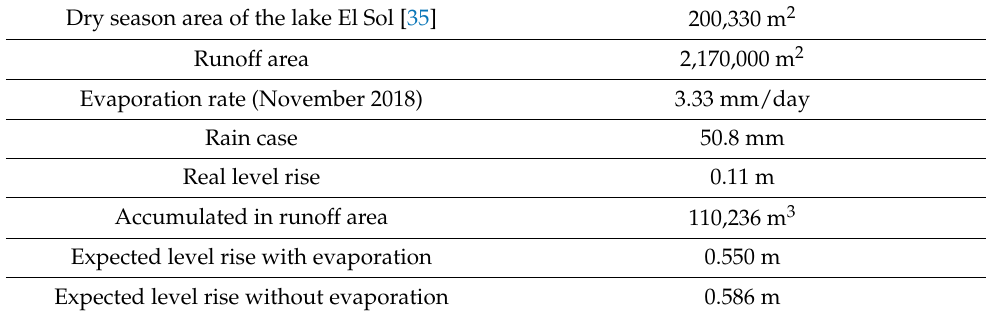
Table 2. Parameters used to calculate the response of Lake El Sol to heavy rainfall on 29 November 2018.